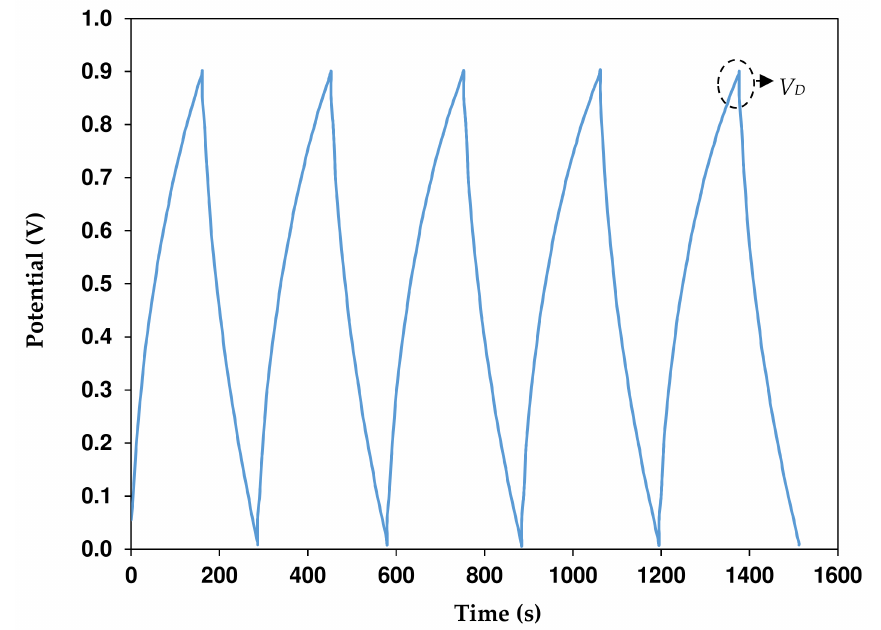
Figure 13. Charge-discharge profiles for the EDLC at 0.25 mA cm − 2 .